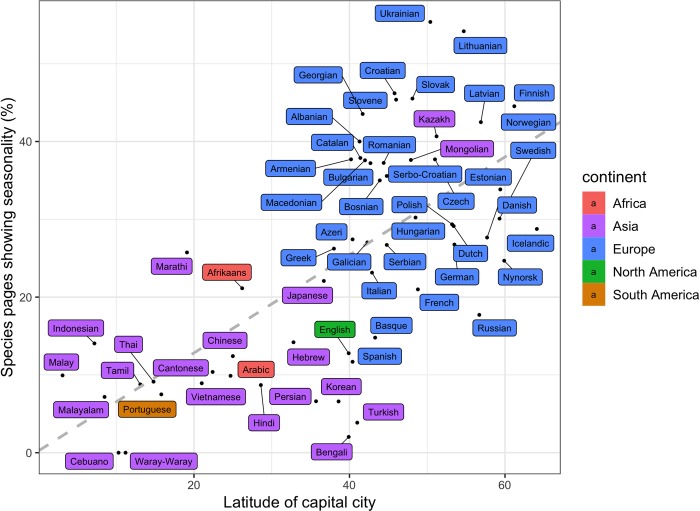
Seasonality and latitude of Wikipedia language editions.The percentage of seasonal pages for the 60 Wikipedia language editions in our data set that have over 100 species pages plotted against the absolute value of the latitude of the capital city of the country or province that accounts for the highest proportion of Wikipedia pageviews in that language (for data used in plots, see S4 Data).